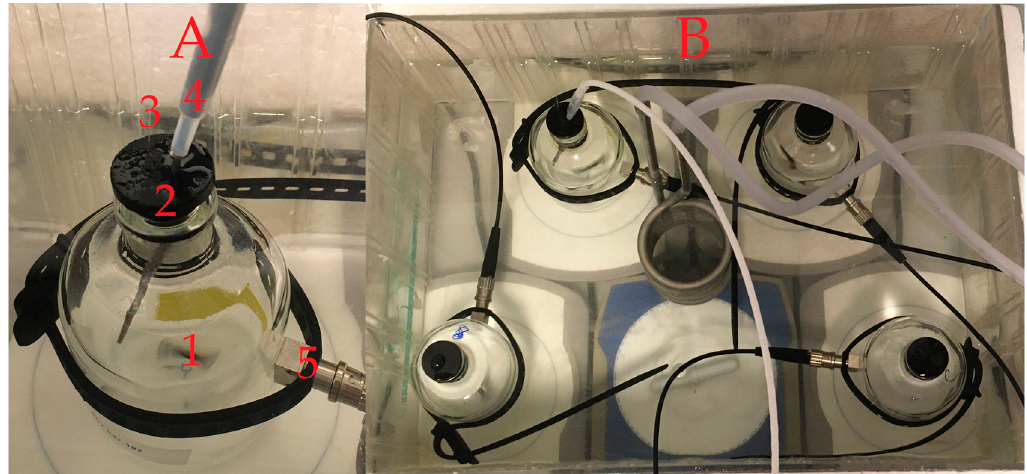
Figure 2. ( A ): Picture of the measurement vial with the glass magnet (1), rubber stopper (2), thin glass capillary (3), temperature probe (4) and O 2 sensor spot with the respective connector (5). ( B ): Three samples and one control measured at the same time within a water bath kept at 22 °C. Primers were trimmed from the ends of the forward and reverse reads using cutadapt, version 1.15